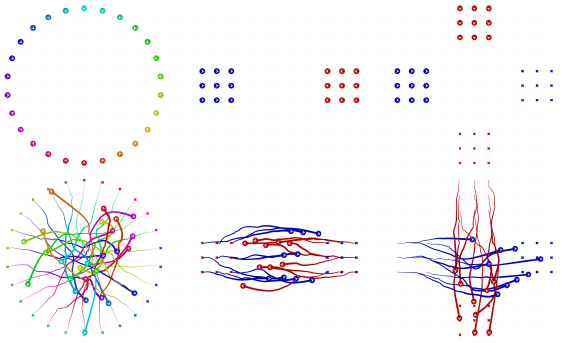
Figure 10. The different scenes used to testing the performance: circle (left), swapping groups (center) and crossing groups (right). All possible combinations of the mentioned val- ues were made, each one defined as a tuple (e.g. ( OSV, circle, 50 , 150 , 80 , 40 , 4) ). Then, they were sent − to each algorithm for running the simulation for 10 sec- onds. The measured value of FPS of each execution was stored and then plotted to different graphs to compare how each parameter influenced the performance. The FPS of each frame is 1 frame . Since the time time in seconds